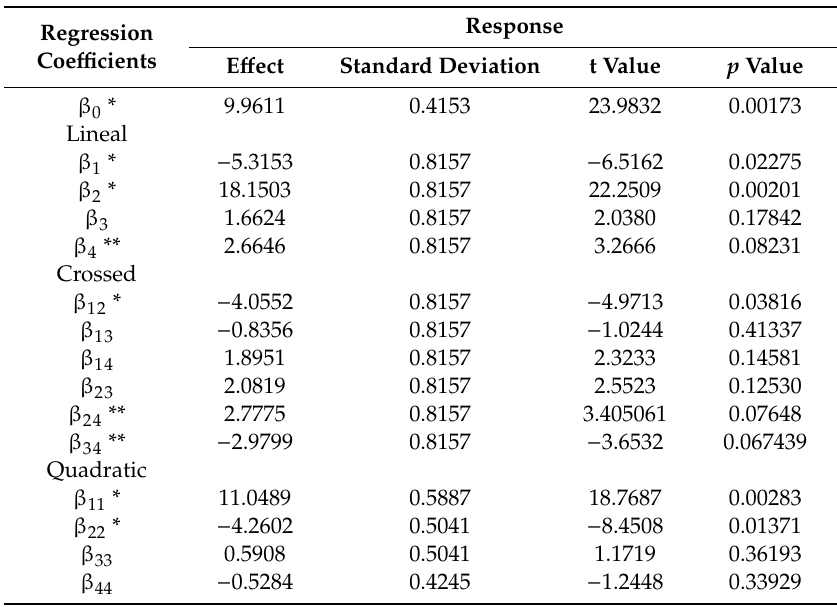
Table 5. Estimated regression coe ffi cients of the adjusted second-order polynomial equation of phosphoric acid